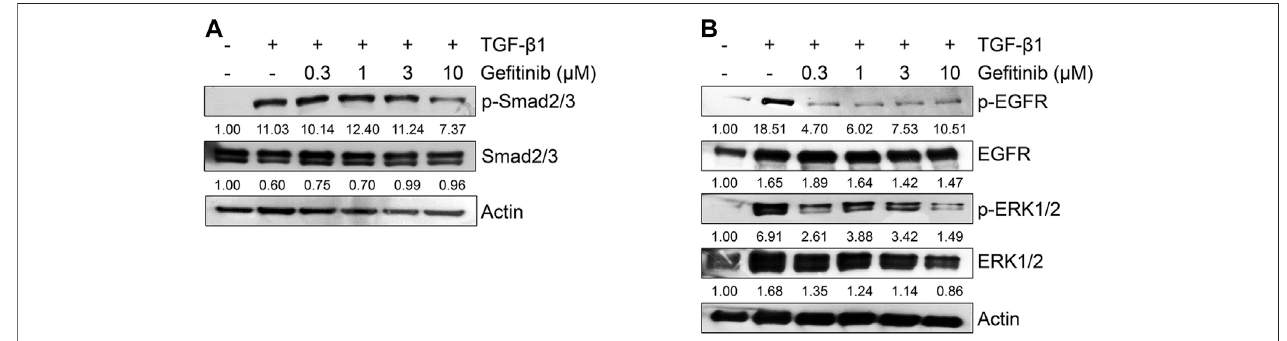
FIGURE 3 | Ge fi tinib inhibits TGF- β 1-induced Smad and non-Smad signaling pathways. Serum-deprived A549 cells were treated with TGF- β 1 (5 ng/ml) or in combinationwithge fi tinibfor48 h (A) or72 h (B) .Proteinexpressionofthephosphorylated formsofSmad2/3,EGFR,andERK1/2andendogenousformsofSmad2/3, EGFR, and ERK1/2 was determined by Western blot analysis. Actin was used as a loading control.